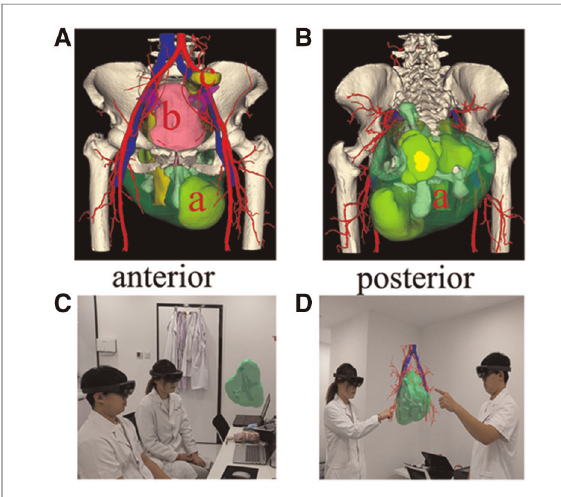
FIGURE 2 The application of 3D reconstruction and mixed reality (MR) technology in our patient. ( A,B ) The 3D reconstruction images accurately displaying the relationship between the teratoma and surrounding tissues through various angles. (a) teratoma; (b) bladder; (c) rectum. ( C,D ) mixed reality (MR) technology showing the spatial location of the teratoma and its orientation with respect to the pelvic cavity. This technology was used to devise a surgical strategy and simulate the surgical